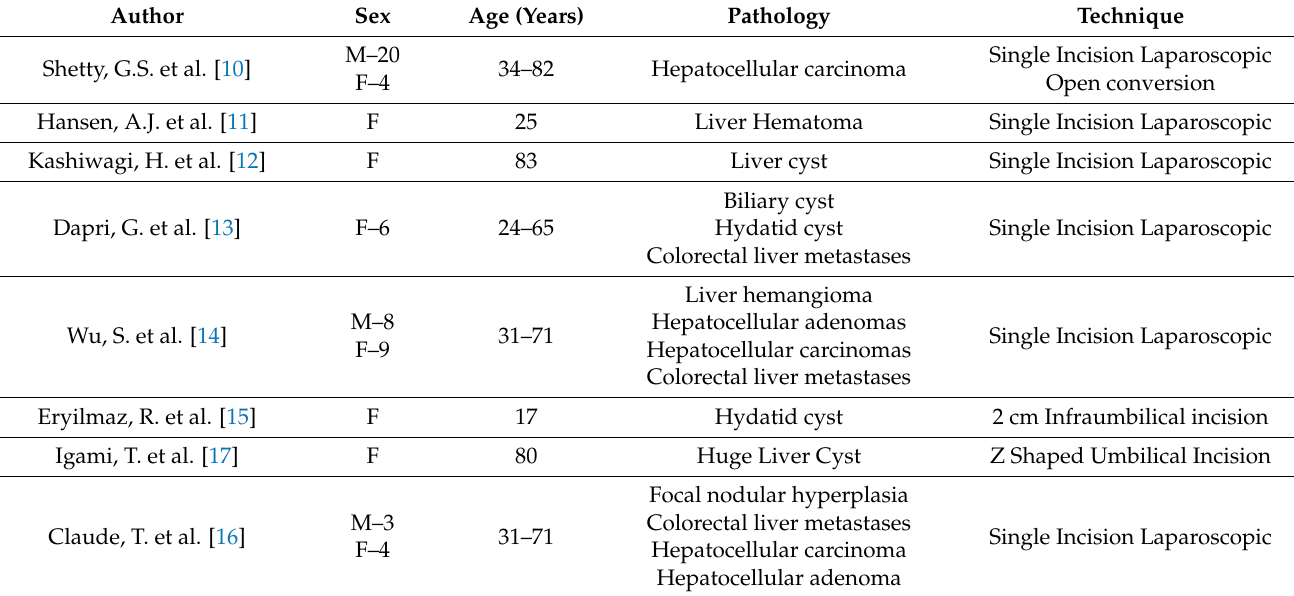
Table 4. General overview of SILS